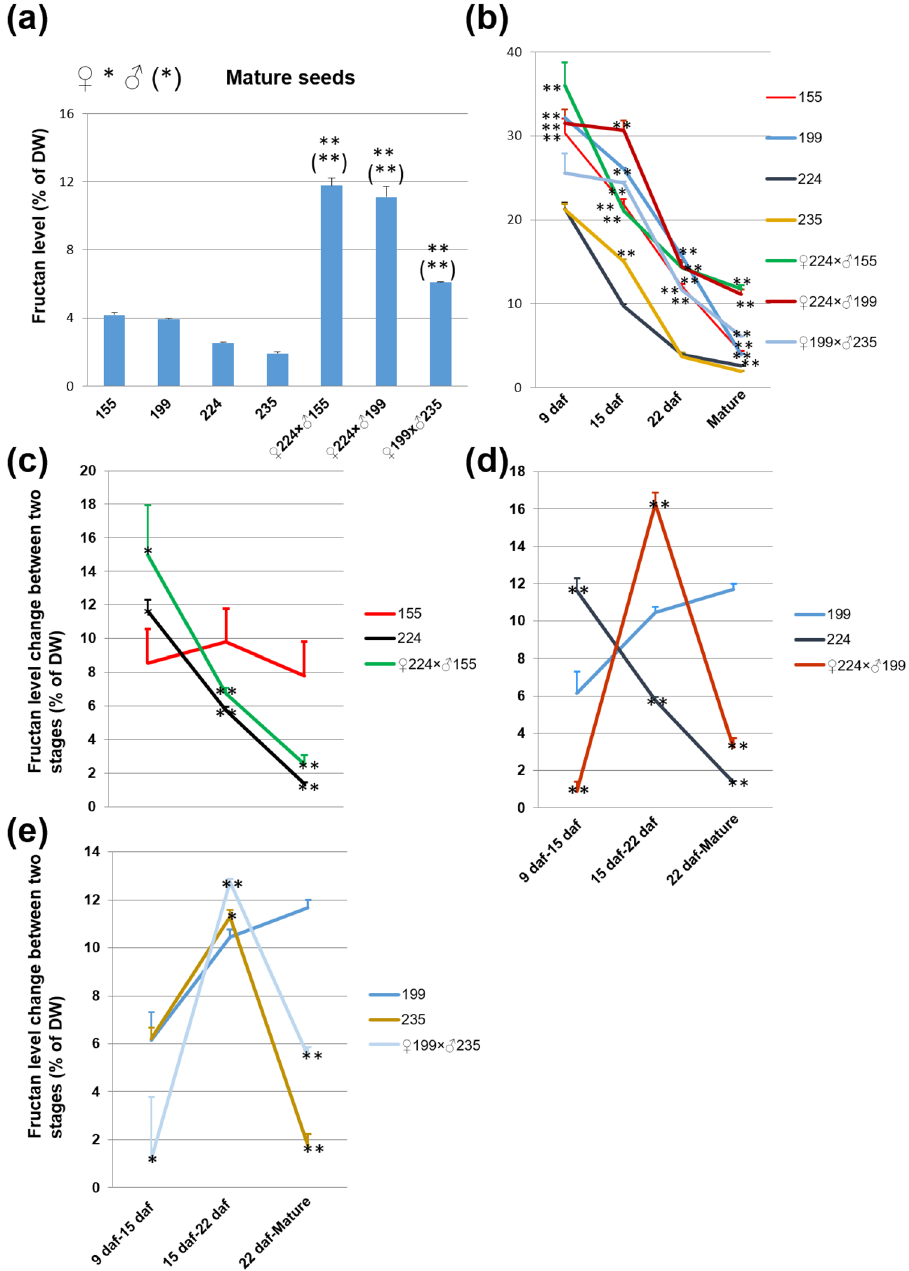
Figure 4. Fructan percentage per unit dry weight (DW) in the high grain fructan barley. ( a ) Fructan level in mature grains of different barley lines, F 3 progenies of G3 (224) × G2 (155), G3 (224) × G1 (199) and G1 (199) × G3 (235), and the parents 155, 199, 224, and 235. ( b ) Fructan level during grain development in the same barley lines. ( c – e ) Fructan level percentage change between two development stages of individual barley lines. Student’s t-test was used (Error bars show SD). ** P < 0.01 is shown for significant differences between the progenies and the parents in ( a ). ** P < 0.01 is shown for significant differences between the sample level and the lowest sample level at different stages in ( b ). * P < 0.05 and ** P < 0.01 are shown for significant differences between the progenies/G3 (224 or 235) and G1/G2(199/155) in ( c – e ). Three biological replicates or grains from three independent plants ( n = 3) were used for